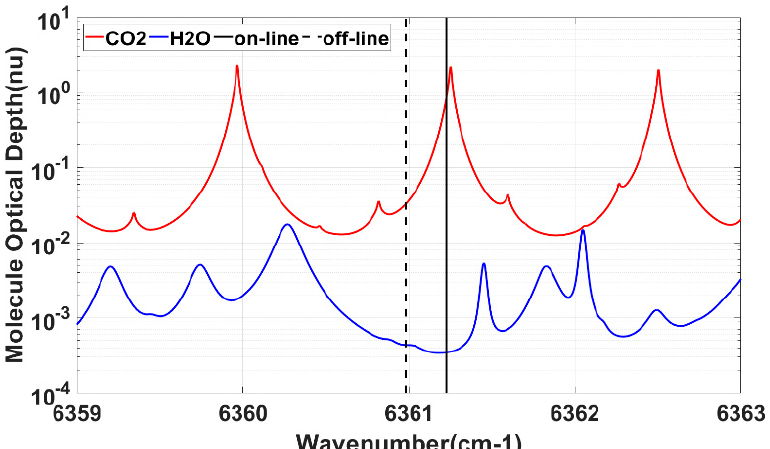
Figure 2. The one-way optical depth of CO 2 (red) and H 2 O (blue) changes with wave numbers utilizing HITRAN 2016 molecular spectroscopic database; the solid black line indicates the on-line position of AC-IPDA lidar, and the dotted black line is the off ‐ line.